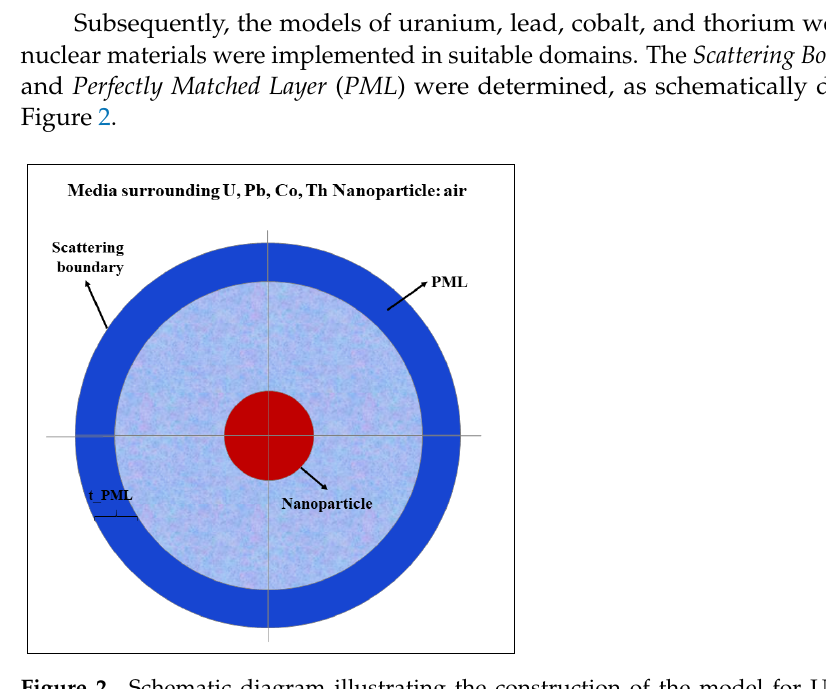
Figure 1. Model geometry of uranium nanoparticle of 40 nm size.